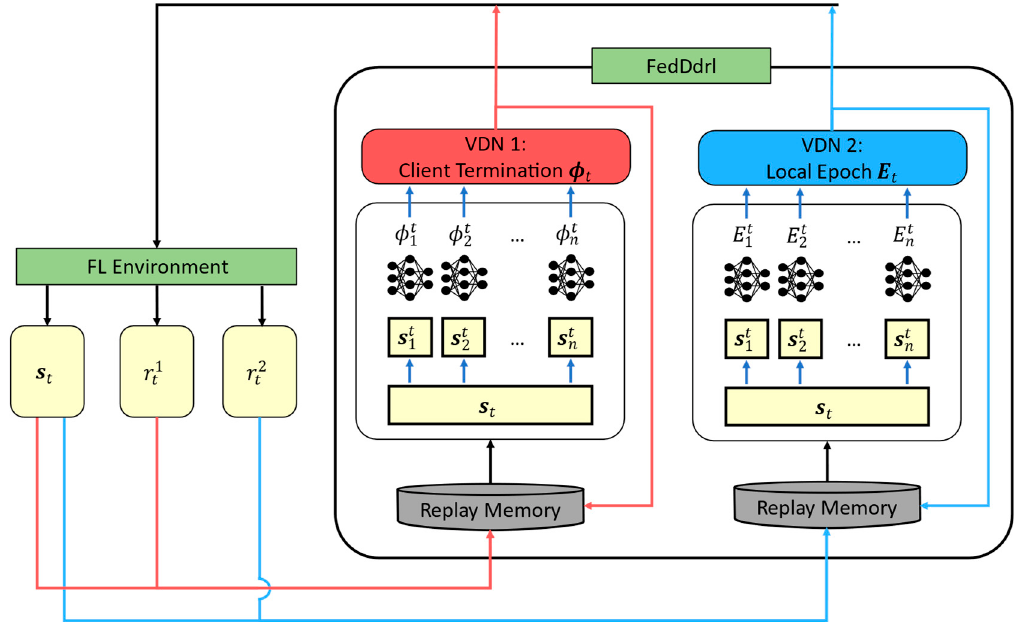
Figure 6. Structure of the proposed FedDdrl algorithm.